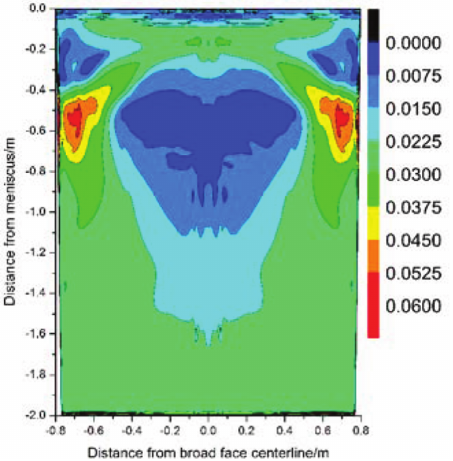
Figure 6: Molten steel velocity distribution at the solidification